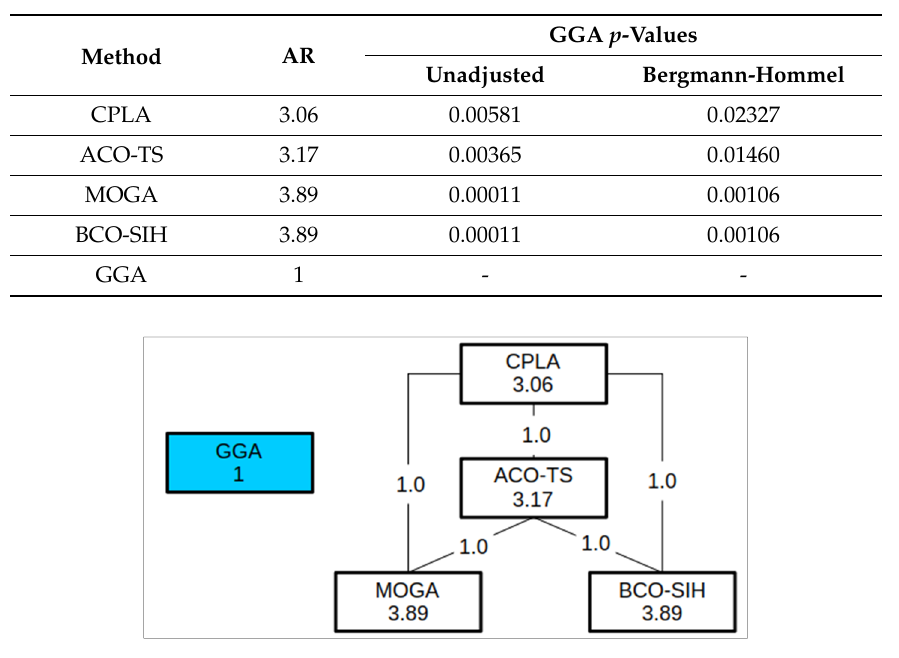
Figure 12. p -values graph of the compared methods.